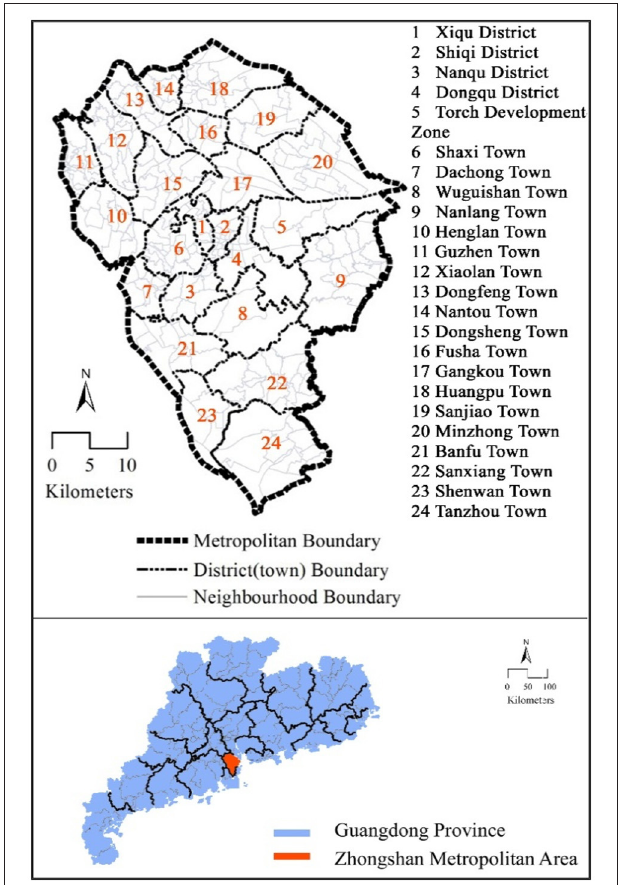
FIGURE 1 | Study area. The upper side of the figure shows the city boundary, district (town) boundary, and the neighborhood boundary of Zhongshan; while the bottom half shows the location of Zhongshan in Guangdong Province.